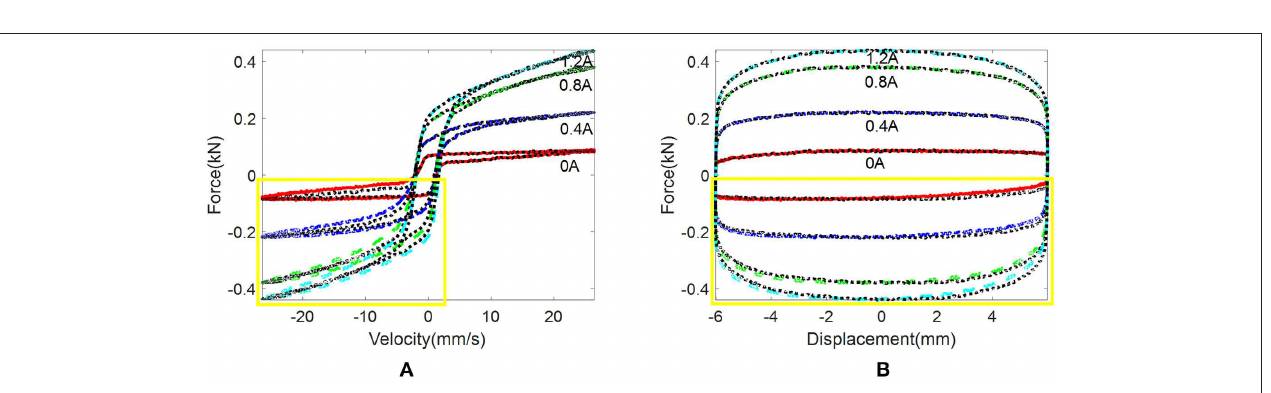
FIGURE 3 | Comparison of experimental results and ideal symmetric loops at amplitude of 6mm and frequency of 0.7 Hz: (A) force vs. velocity and (B) force vs. displacement.